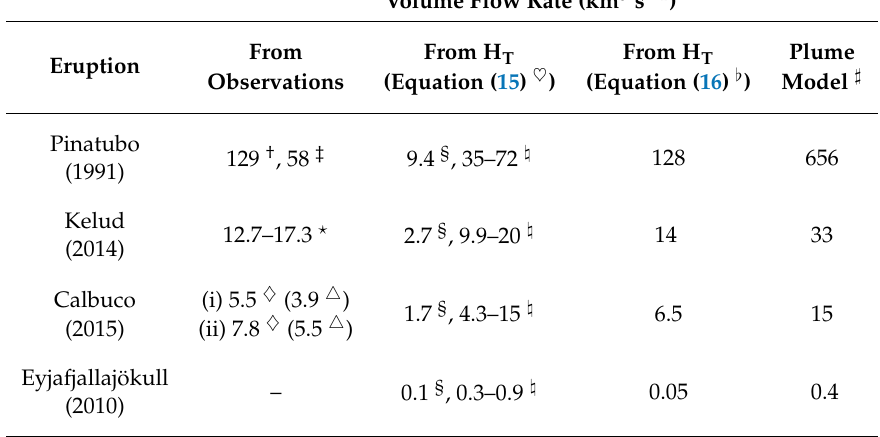
Table 3. Volume flow rates of material (gas and ash) into the umbrella cloud, estimated from observations, from the maximum plume height ( H T ) or from plume models. The sources of data are indicated using symbols as follows:- ♥ [24], (cid:91) [33], (cid:93) [35], † [4], ‡ [5], (cid:63) from − 50 ◦ C and − 30 ◦ C 11 µ m brightness temperature contours [36] and ♦ [32] with N = 0.014 s − 1 ( (cid:52) with N = 0.02 s − 1 ). The constant of proportionality in Equation (15) is determined from large-eddy and plume model simulations described in § [11] and (cid:92) [14]. Volume Flow Rate (km 3 s − 1 ) From From H T From H T Plume Eruption Observations (Equation (15) ♥ ) (Equation (16) (cid:91) ) Model (cid:93)